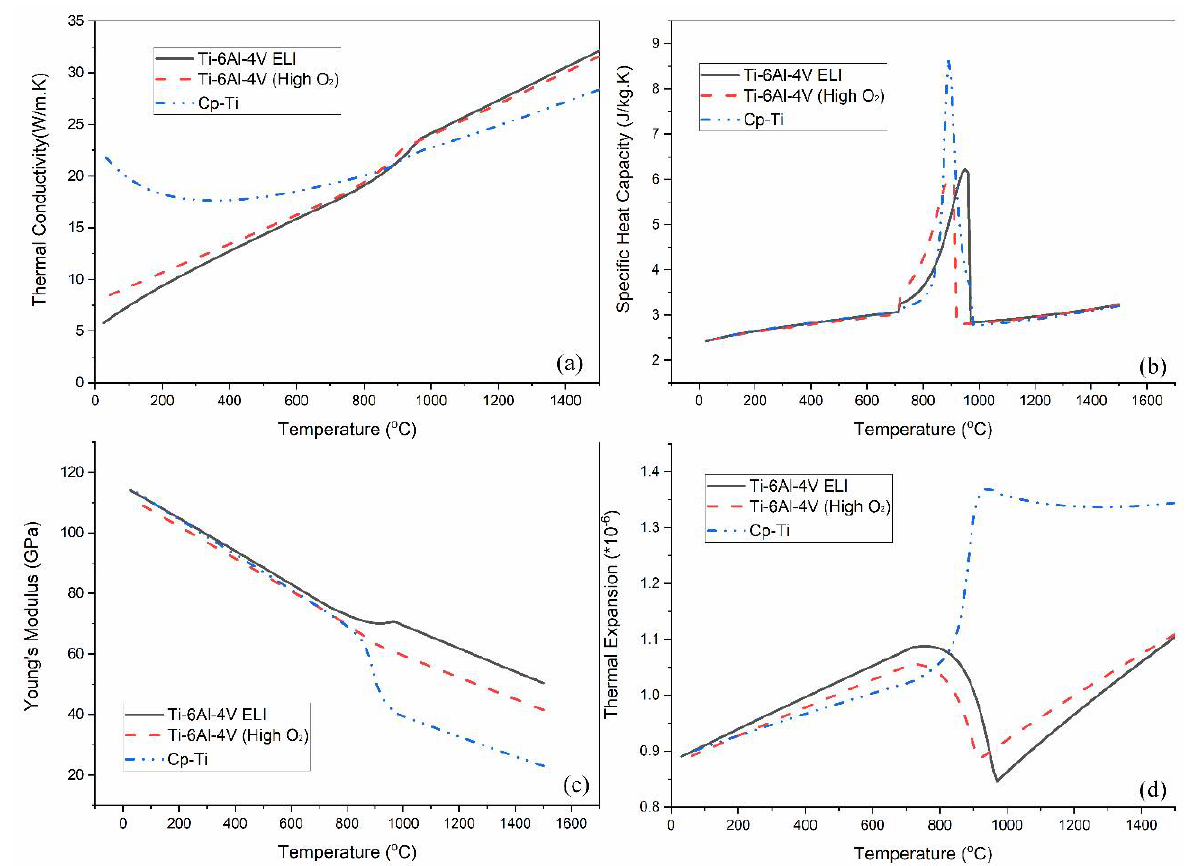
Figure 3. Physio-thermal properties vary with the temperature of Ti−6Al−4V ELI, Ti−6Al−4V (high O 2 ), and commercially pure titanium (Cp−Ti). ( a ) Thermal conductivity, ( b ) specific heat capacity, ( c ) Young’s modulus and ( d ) thermal expansion.